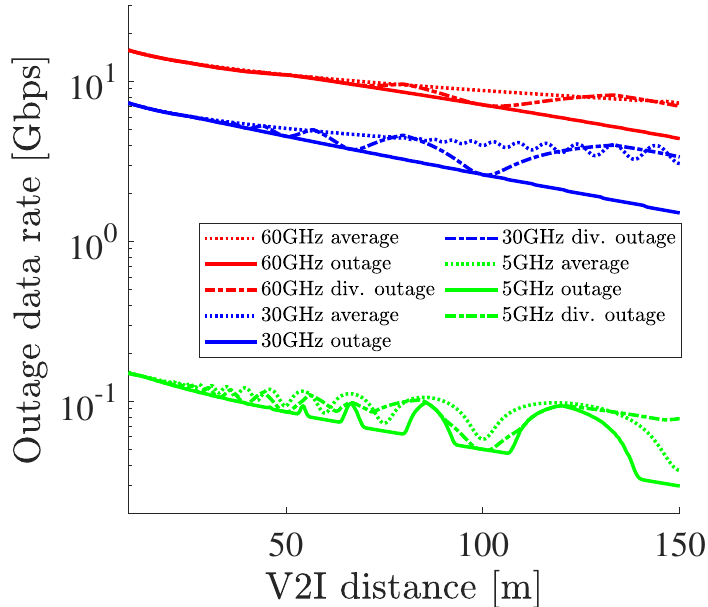
Figure 9. The 0.01% outage capacity with and without height diversity and the average capacity without height